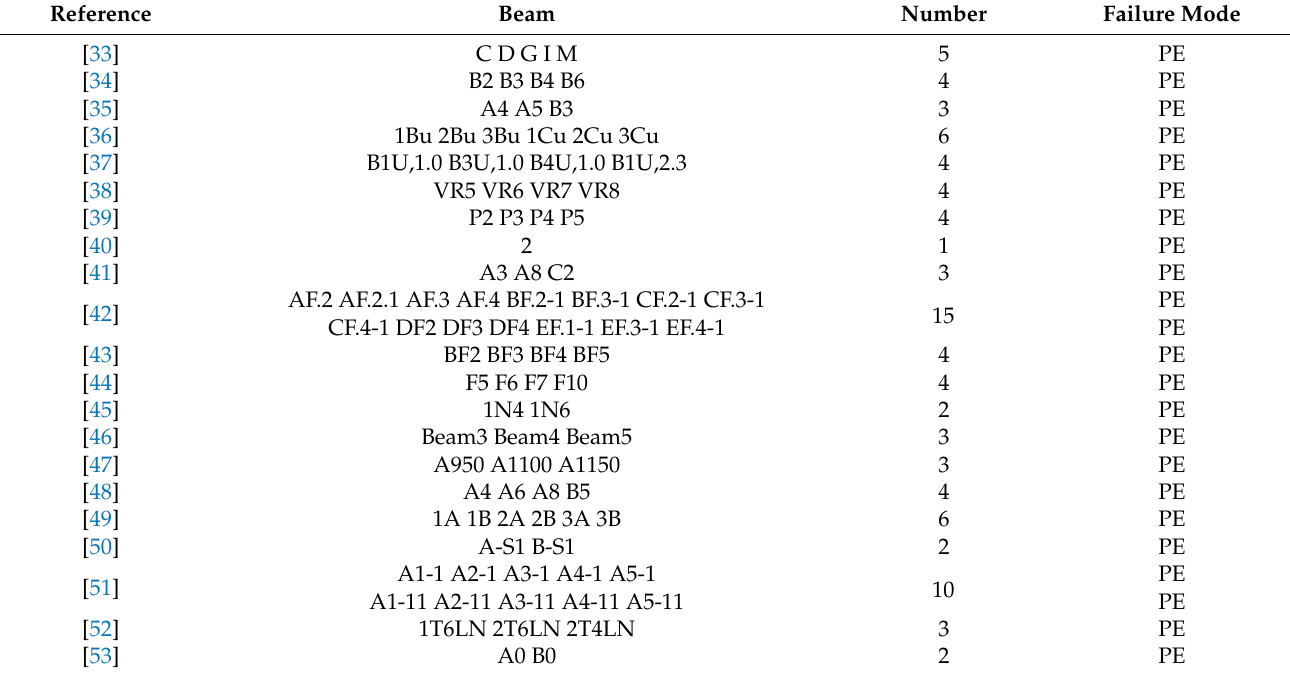
Table 1. Data sources and failure